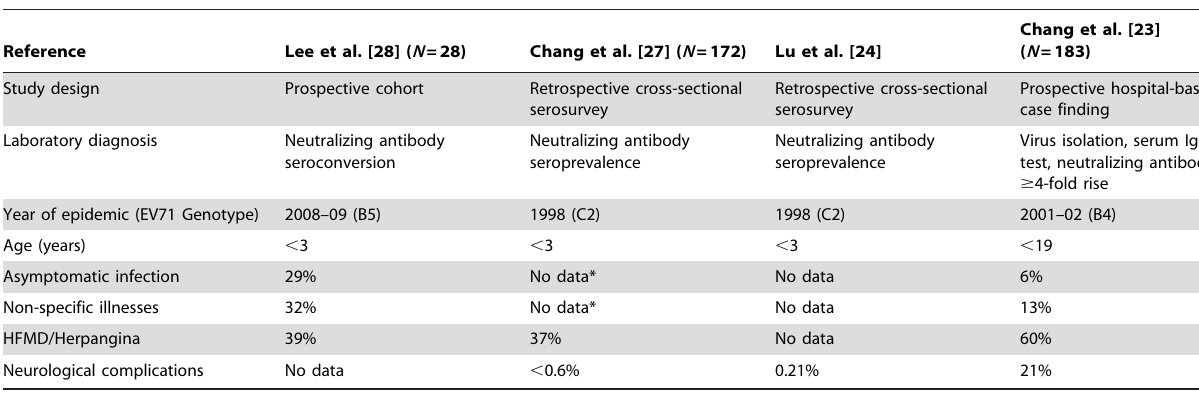
Table 4. Comparisons on clinical spectrum of enterovirus 71 infections in